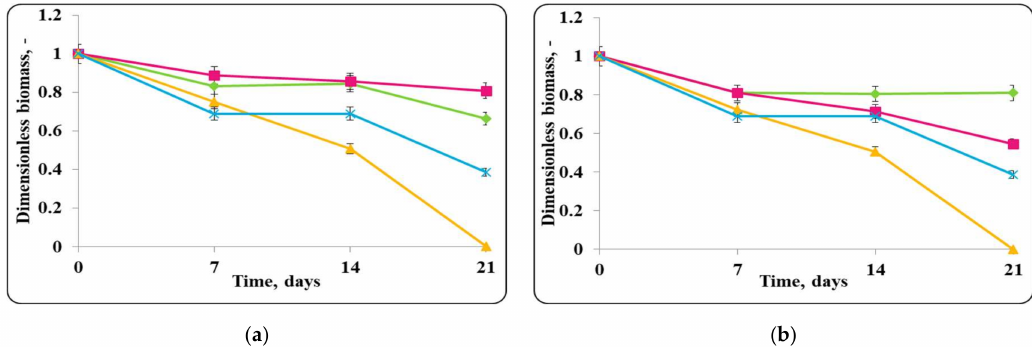
Figure 11. ( a ) free lactobacilli cells; ( b ) encapsulated lactobacilli cells. Changes in the dimensionless biomass of Lb. helveticus 2/20 and S. aureus ATCC 25923 in MRS broth at 4 ± 2 ◦ C. Legend: Green (cid:117) : Lb. helveticus 2/20 population following its inoculation; Pink (cid:4) : Lb. helveticus 2/20 population following its co-inoculation with S. aureus ATCC 25923; Blue : × S. aureus ATCC 25,923 population fol- lowing its direct inoculation; Yellow (cid:78) : S. aureus ATCC 25923 population following its co-inoculation with Lb. helveticus